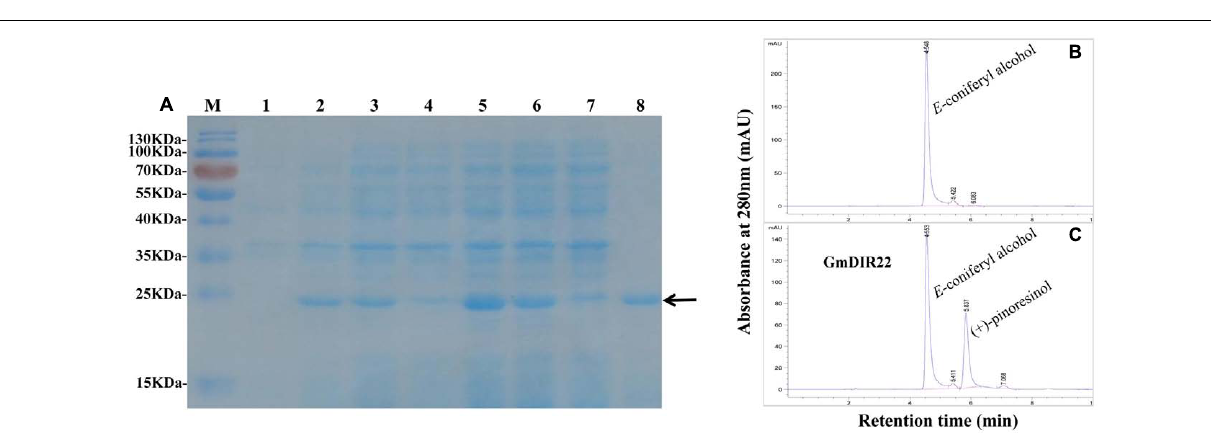
FIGURE 5 | Analysis of GmDIR22 dirigent activity by HPLC. (A) Expression of recombinant GmDIR22 protein in E. coli BL21 (DE3) was induced using 0.5 mM IPTG at 37 ◦ C for 1–6 h and purified from the soluble fraction of induced cells using resin with affinity for the His-Tag. Lane 1 pET-29b(+) vector induced by IPTG for 3 h, Lane 2–7 pET29b(+)-GmDIR22 induced by IPTG for 1, 2, 3, 4, 5, and 6 h, Lane 8 purified soluble GmDIR22 protein with Nickel-CL agarose affinity chromatography. (B) HPLC chromatogram at 280 nm absorption of E -coniferyl alcohol at retention time 4.5 min. (C) HPLC chromatogram at 280 nm absorption of reaction mixture